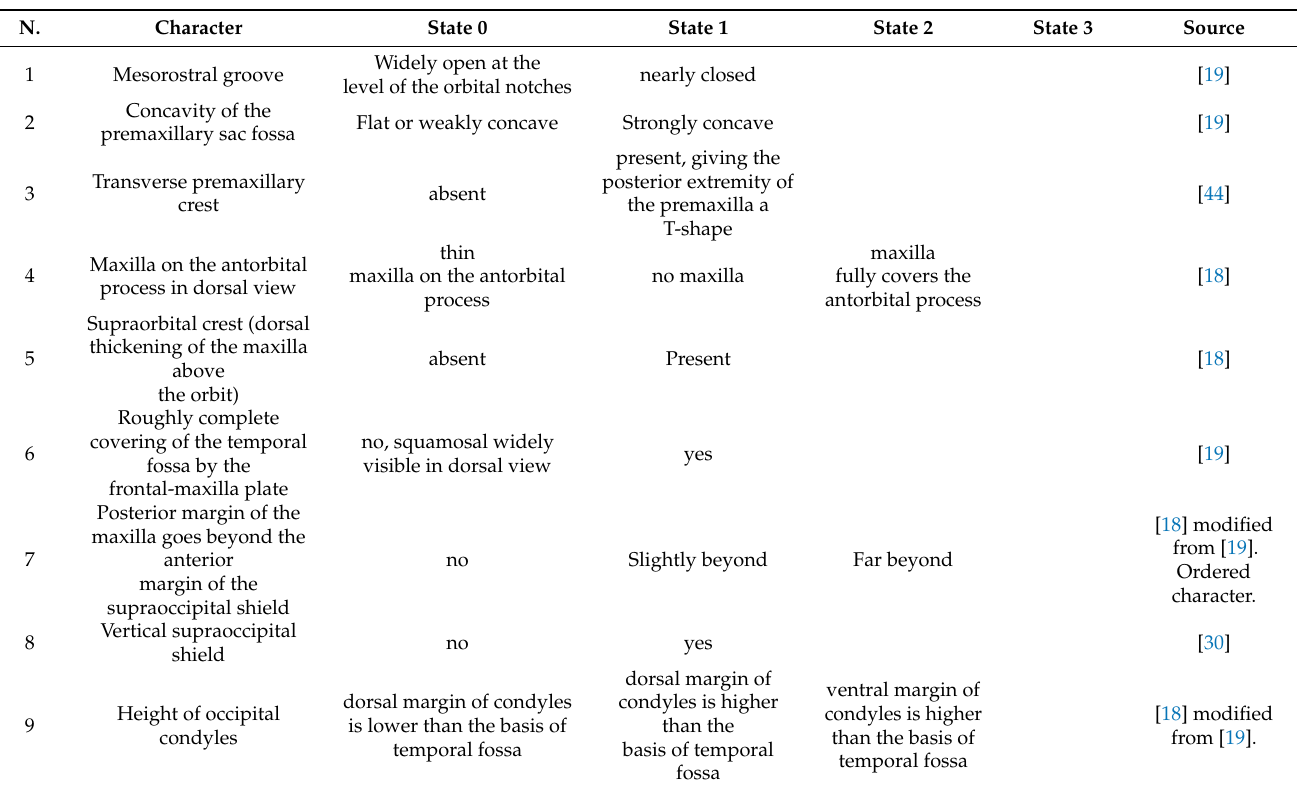
Table A1. Description of character states used in the phylogenetic